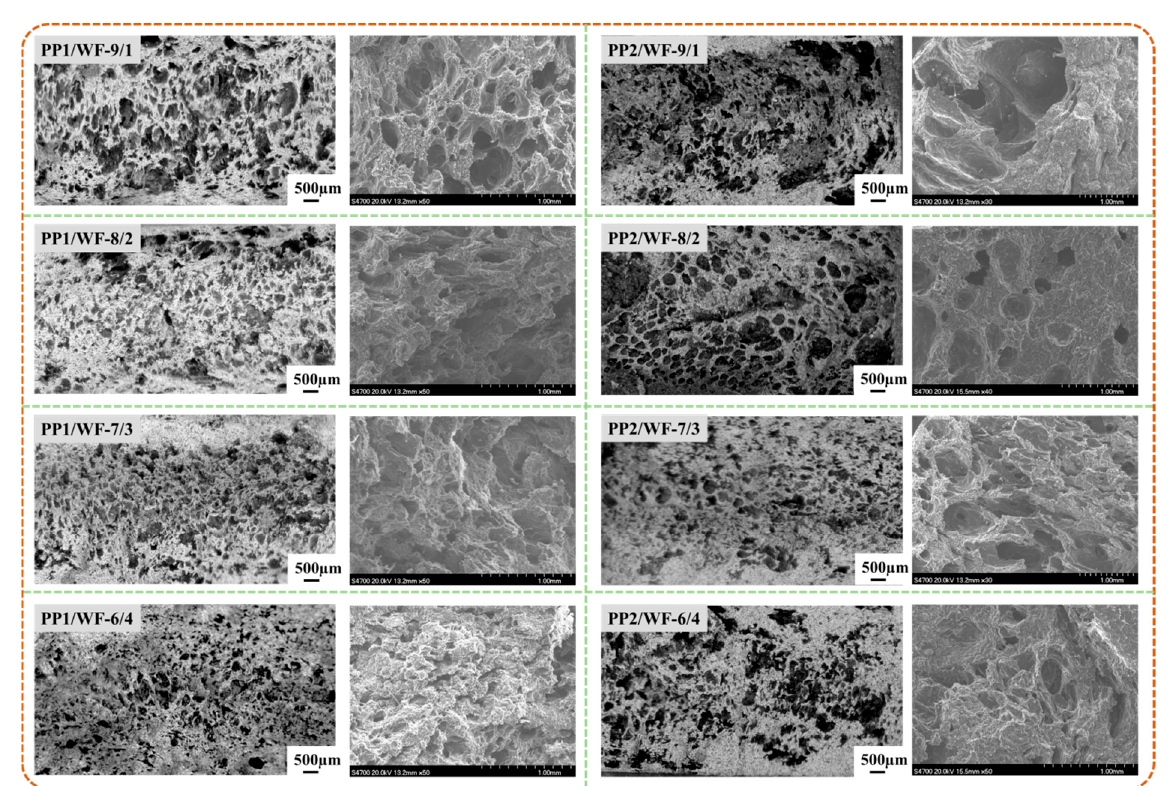
Figure 11. Cell morphology of axial section of samples with different WF contents.